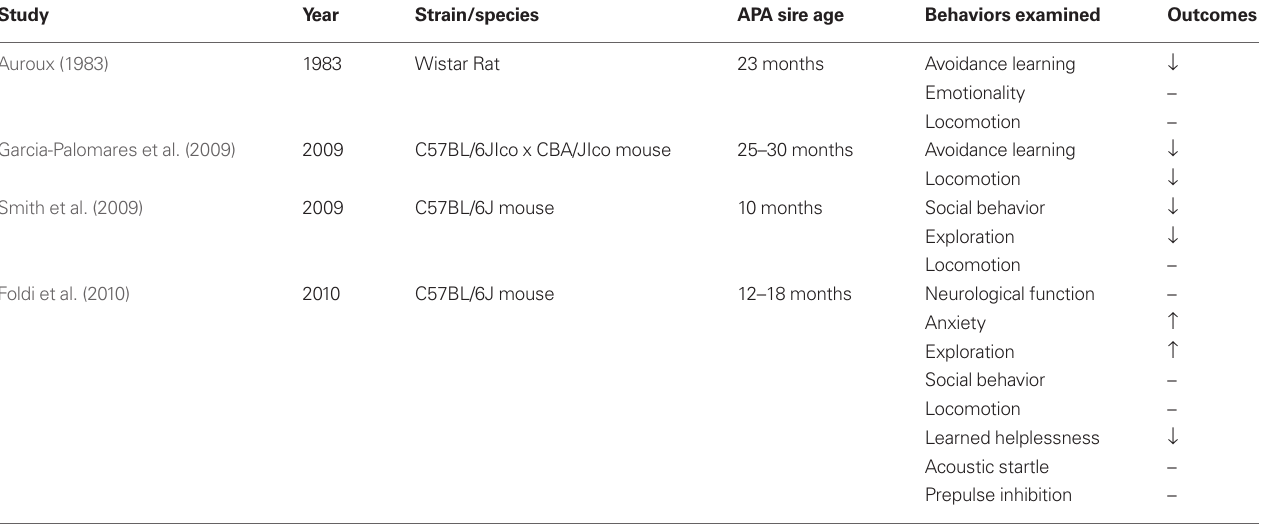
Table 1 | Behavioral phenotype in offspring of rodent APA